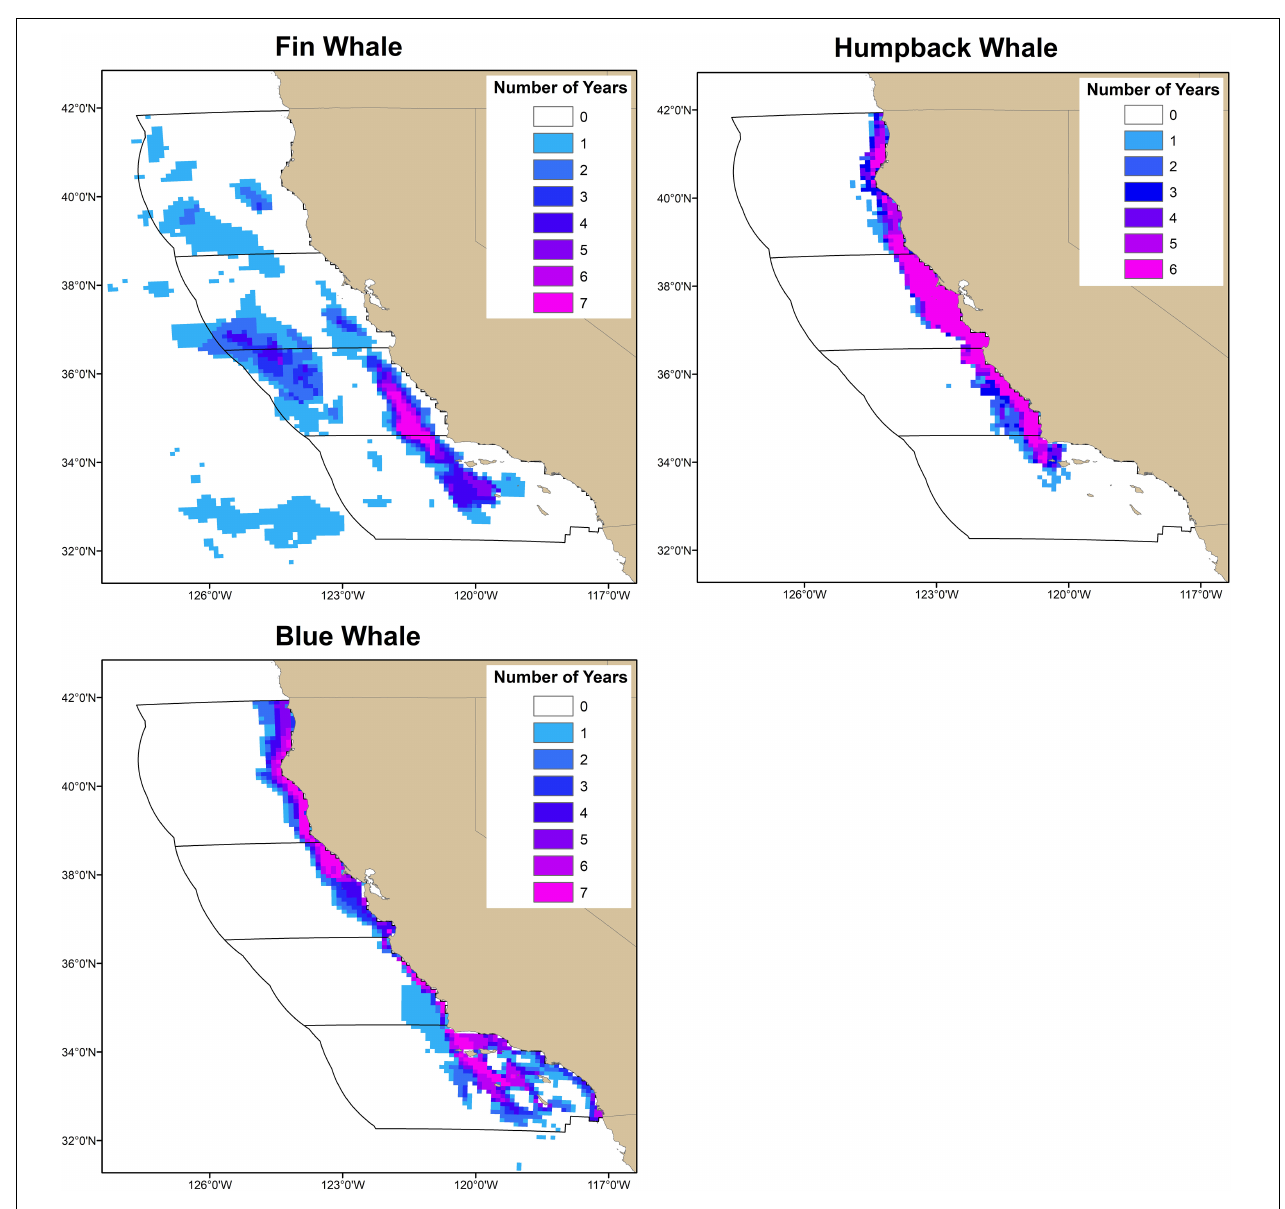
FIGURE 6 | Interannual variability in locations containing the highest predicted number of whales was assessed using the number of years (7 years for fin and blue whales; 6 years for humpback whales) the prediction in each grid cell was among the highest 5% of all predictions. Although these analyses were conducted using all whale predictions (i.e., from the coast of California out to 300 nmi), the regions used to assess ship-strike risk (black polygons) are also shown. Areas with the highest predicted number of whales were consistent among years as were areas that never contained the highest predictions.